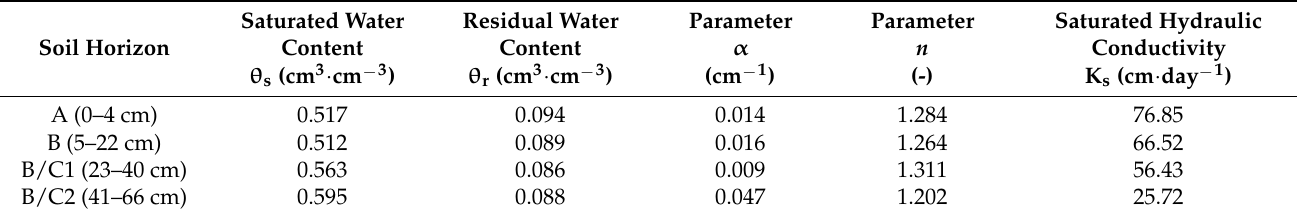
Table 2. Hydrophysical characteristics of each horizon of the soil